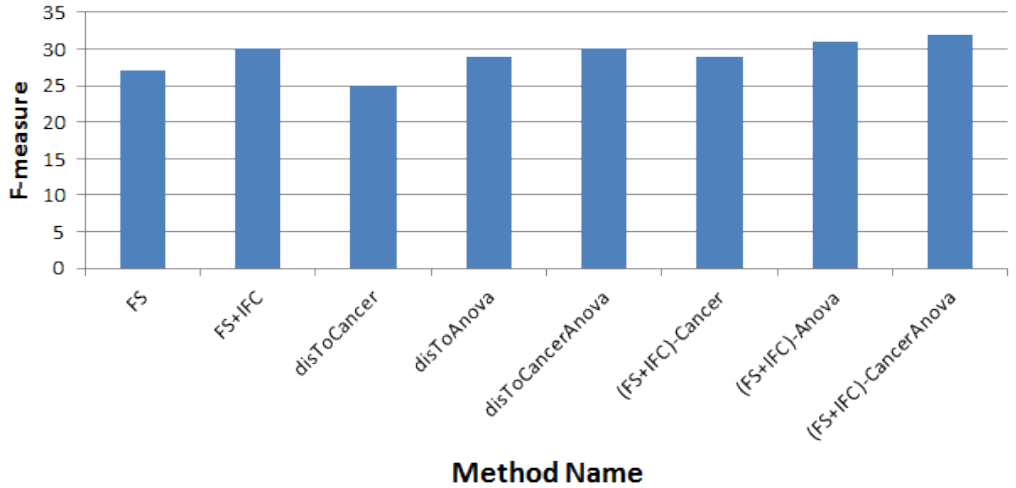
Figure 5: Comparison of all the proposed methods with each other. The method (FS+IFC)- DisToCancerAnova which considers network contextual information outperforms all other pro- posed methods.